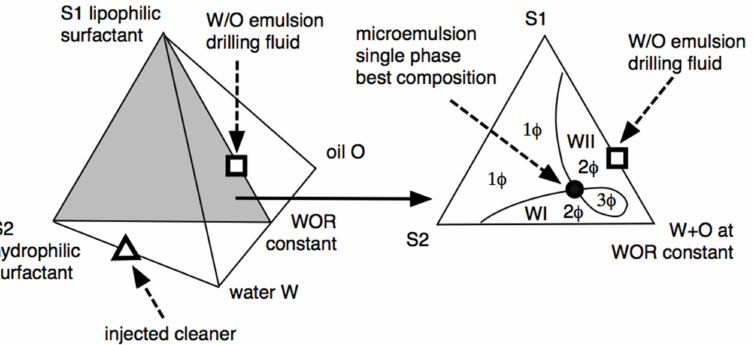
Figure 7. Ternary and quaternary diagrams showing the different phase behavior zones and the optimum formulation point (black circle) in which the single phase is attained at the minimum surfactant concentration